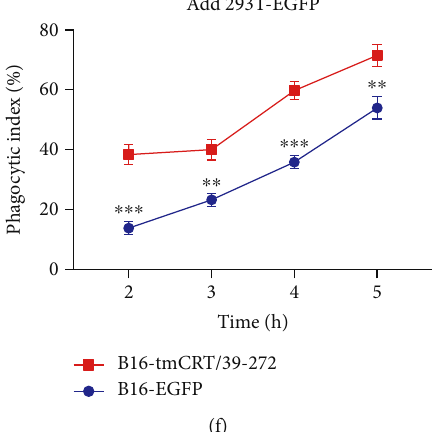
Figure 2: tmCRT/39-272 enhanced macrophage phagocytosis and M2 macrophage polarization. (a) Female C57BL/6 mice ( n = 5 ) were s.c. injected with B16-EGFP or B16-tmCRT/39-272 cells ( 5 × 105/100 μ L/mouse) and sacri fi ced 18 days postinoculation to obtain the solid tumors. B16-EGFP and B16-tmCRT/39-272 tumor tissues were digested with collagenase Ⅳ (1 mg/mL) and DNase Ⅰ (0.05 mg/mL). Single cells were fi ltered through a 70- μ m cell strainer and stained with fl uorescence-labeled anti-F4/80 and anti-CD206 antibodies. The percentage of F4/80 + CD206 + M2 macrophages among the tumor cells was analyzed by FACS. (b) Immuno fl uorescence staining of tumor tissues with FITC-labeled anti-CD206 antibody (green) and DAPI (blue). Images were acquired by laser-scanning confocal microscopy. (c and d) FACS dot plots and the statistical results of percentage of F4/80 + CD206 + cells and CD11b + TNF- α + cells from C57BL/6 mouse bone marrow cells analyzed by fl ow cytometry. (e) B16-EGFP or B16-tmCRT/39-272 cells were labeled with CFSE and cocultured with macrophages at a ratio of 3:1 for 2h, 3h, and 4 h. The cells were stained with fl uorescence-labeled antibody against anti-CD11b and the phagocytic capability of the macrophages was analyzed by fl ow cytometry. (f) 293T-EGFP cells (labeled with dye) were added to macrophage cocultured with B16-EGFP or B16-tmCRT/39-272 cells. The cell ratio was 1:1:3 (macrophage:293T-EGFP:B16-EGFP or B16-tmCRT/39-272). At 2 h, 3h, 4h, and 5h, the cells were collected for staining with fl uorescence-labeled anti-CD11b antibody and the phagocytic capability of the macrophages on 293T-EGFP cells was assessed by fl ow cytometry. The experiments were repeated three times. ∗ P < 0 : 05 , ∗∗ P < 0 : 01 , ∗∗∗ P < 0 : 001